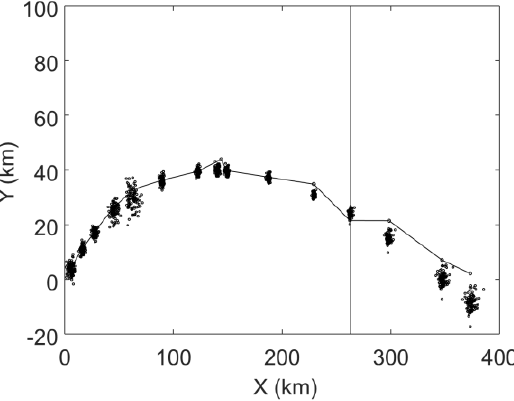
Figure 3. The matching results of the multiple hypotheses tracking-ensemble Kalman filter (MHT- EnKF).